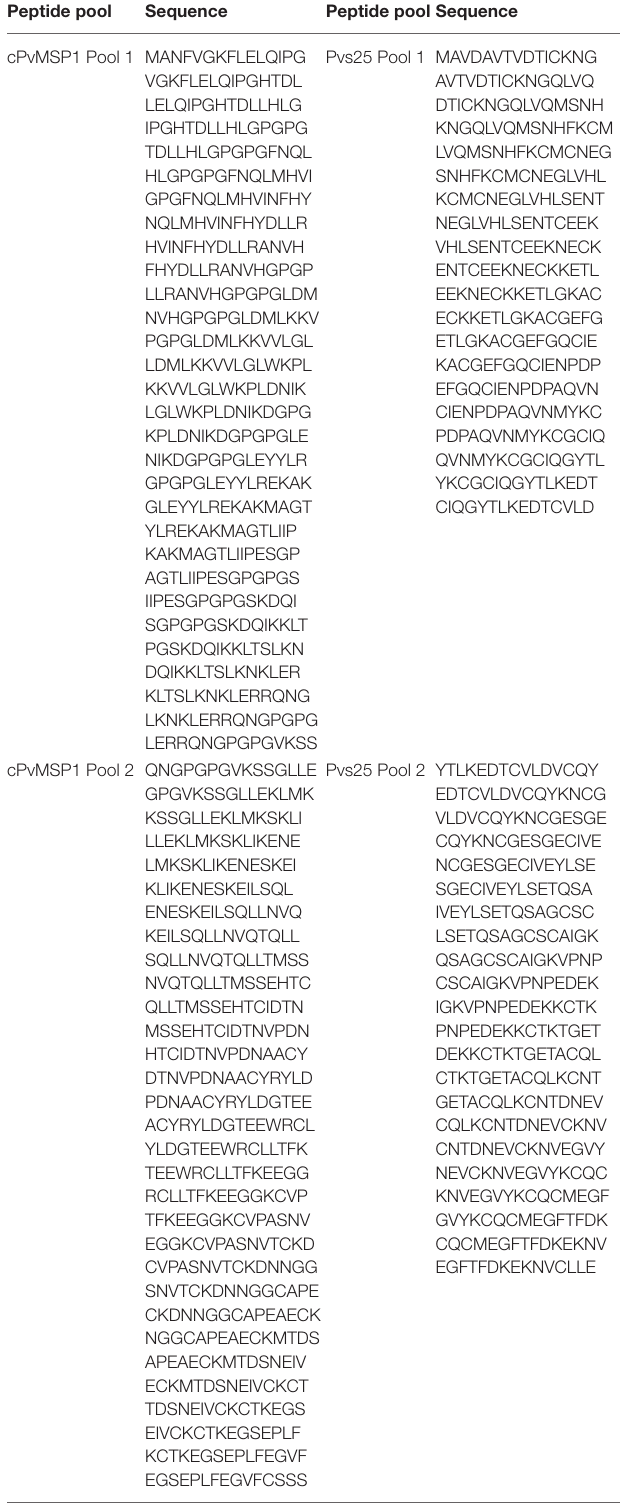
Peptide pools used for stimulation of T cells for assessment of cytokine production after the second immunization. cPvMSP1 Pool 1 represents MSP1T cell epitopes present in cPvMSP1. Pool 2 represents the extended MSP1 19 kD protein fragment. Pvs25 pools 1 and 2 cover the full sequence of the Pvs25